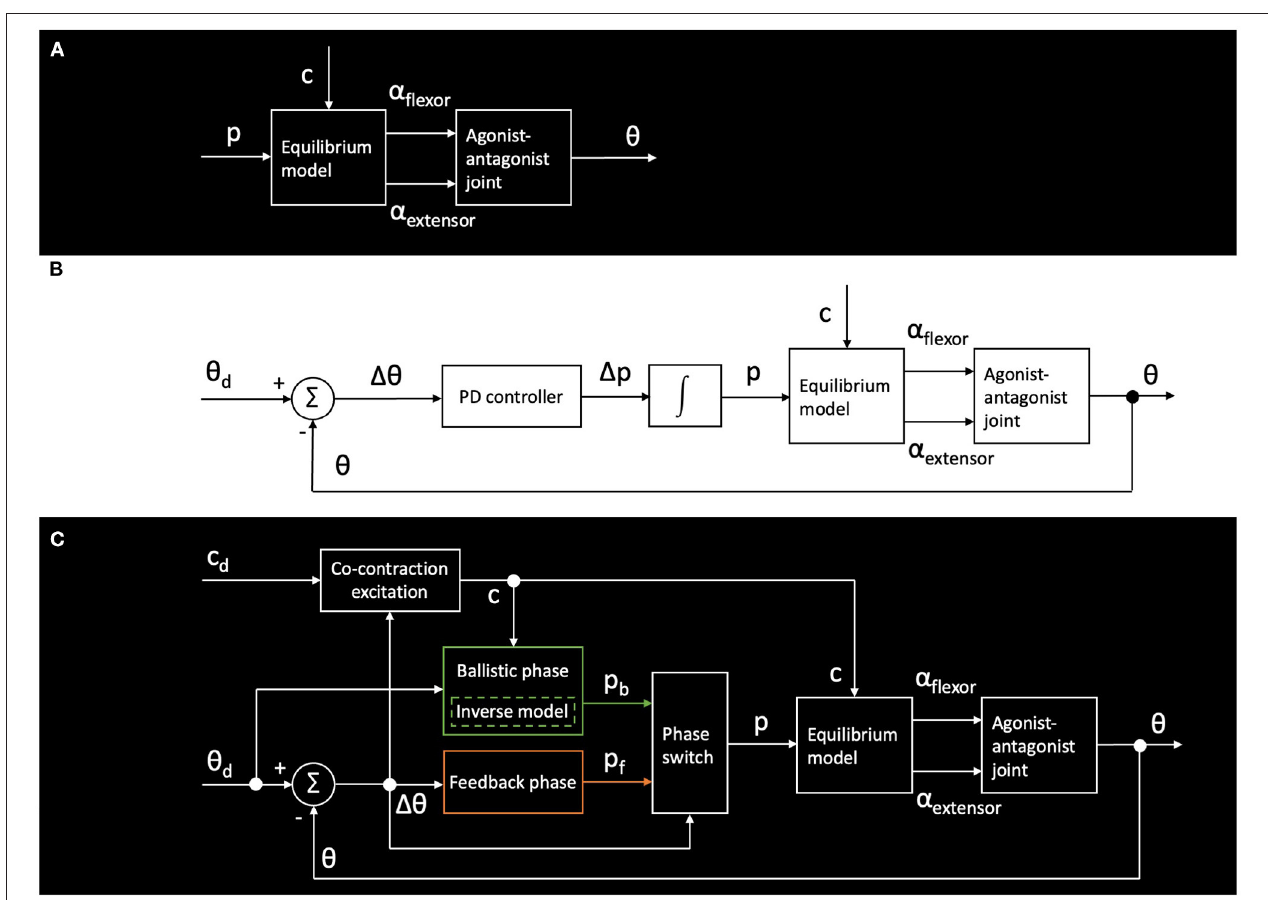
FIGURE 5 | Example control architectures (for individual joints) used for the GummiArm experiments described here. (A) shows open-loop control using the equilibrium point p of and co-contraction level c of the joint. (B) shows a standard closed-loop approach with Proportional-Derivative (PD) control. (C) shows a bio-inspired dual-phase control for fast ballistic movements, as described in Stoelen et al.